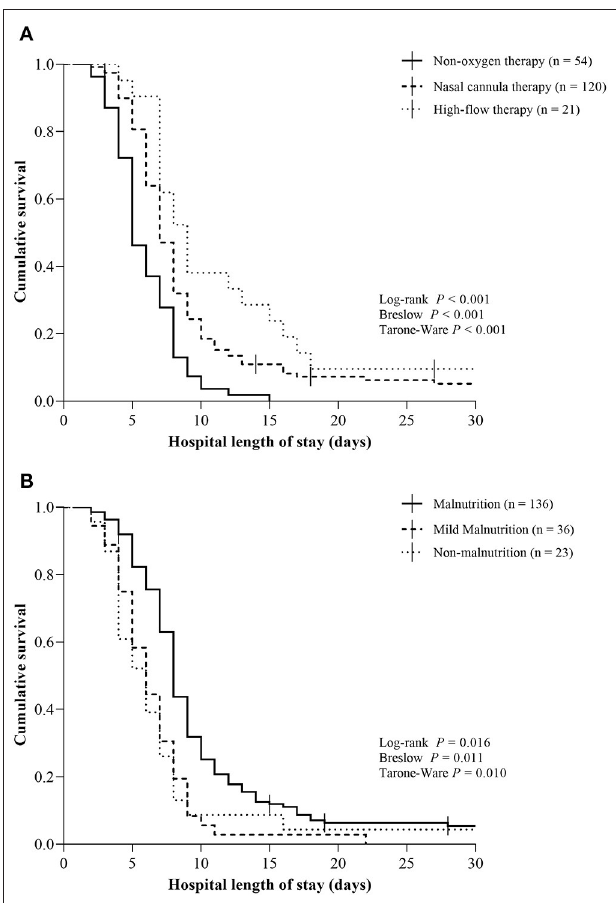
FIGURE 1 | Kaplan–Meier curves for hospital length of stay according to oxygen therapy requirement and Prognostic Nutritional Index categories in patients with moderate to severe Coronavirus Disease 2019. (A) Non-oxygen therapy, nasal cannula therapy, and high-flow therapy; (B) Malnutrition (PNI < 40), mild-malnutrition (PNI 40–45), and non-malnutrition (PNI > 45). Vertical bars present single censored events (deaths). Both analyses represent 195 total patients. COVID-19, Coronavirus Disease